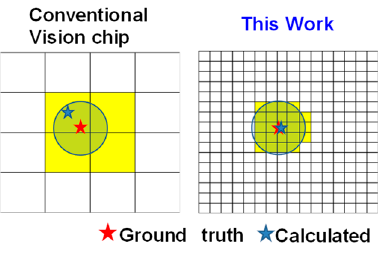
Figure 4. Improvement of sensing accuracy.